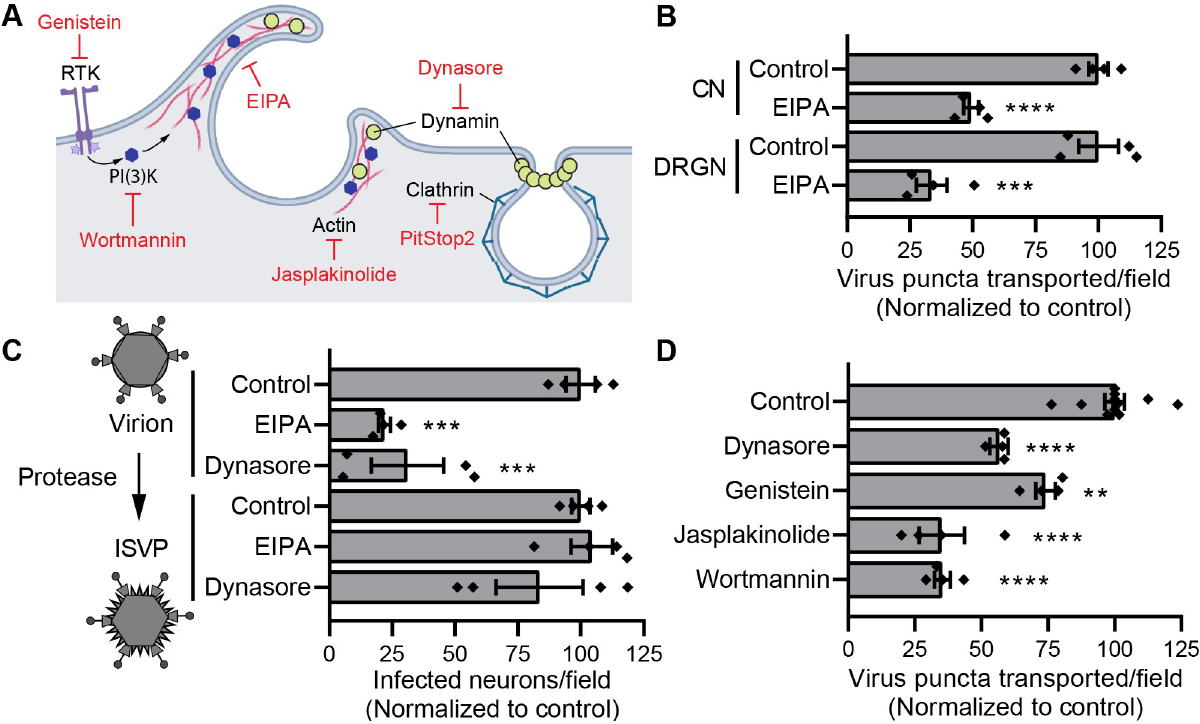
Fig 6. Macropinocytosis-mediated entry is required for reovirus neuronal transport and infection. (A) Schematic shows host factors mediating endocytic pathways and corresponding small molecule inhibitors (red) (RTK, receptor tyrosine kinase). (B, D) CNs and DRGNs (B) or CNs (D) were treated with the drugs shown (Table 1), adsorbed with T3SA+ virions, and viral puncta transported per field-of-view were enumerated following treatment. (C) CNs were treated with the drugs shown (Table 1), adsorbed with T3SA+ virions or ISVPs at an MOI of 50,000 particles/cell, and infectivity was quantified 24 h post-adsorption. In B-D, bars indicate means normalized to untreated controls. Error bars indicate SEM. Data are representative of at least two independent experiments each with one to three samples. Individual data points are averages from 8 to 12 fields-of-view per sample. Values that differ significantly from control by ANOVA and Dunnett’s test are indicated ( �� , P < 0.01; ��� , P < 0.001; ���� , P < 0.0001).